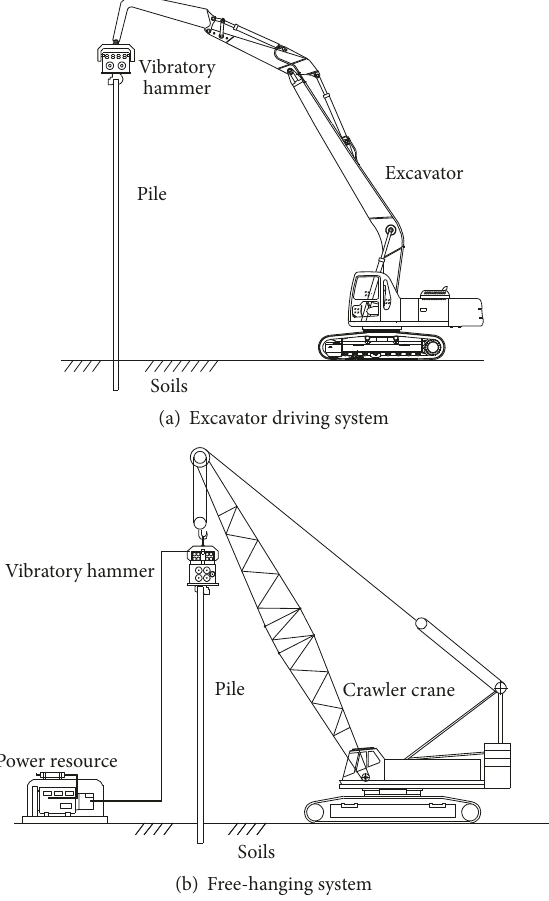
Figure 2: Two vibratory-driver